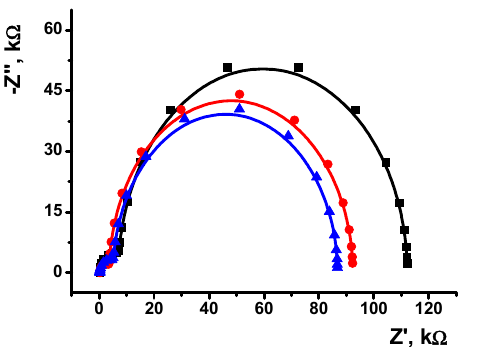
Figure 13. Nyquist diagrams obtained for idarubicin determination in standard solution (black), Zavedos ® medical preparation (red), artificial mixture of idarubicin standard solution and lactose monohydrate (blue) on PAB-2/DNA-MB, EIS, 0.1 M HEPES buffer containing 0.03 M NaCl, pH 7.0 in the presence of equimolar mixture of 0.01 M [Fe(CN) 6 ] 3 − and [Fe(CN) 6 ] 4 − ions.